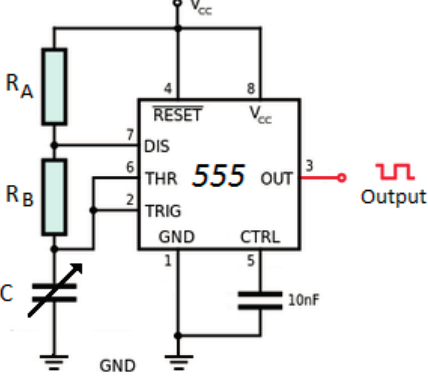
Figure 4. Astable vibrator based on the CI CA555 with frequency depending on a capacitive sensor [16].